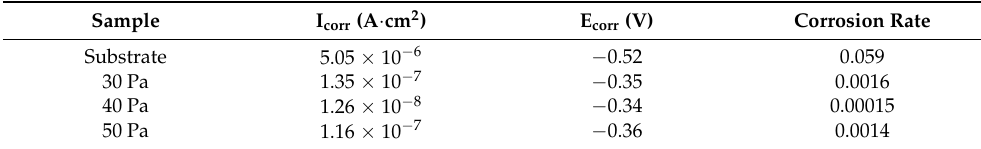
Figure 9. Potentiodynamic polarization curves of Nb-Zr alloying layers prepared with 316L substrate and at pressures of 30 Pa, 40 Pa, and 50 Pa. Table 4. Corrosion parameters of Nb-Zr alloying layer prepared by 316L substrate and at 30 Pa, 40 Pa, and 50 Pa of gas